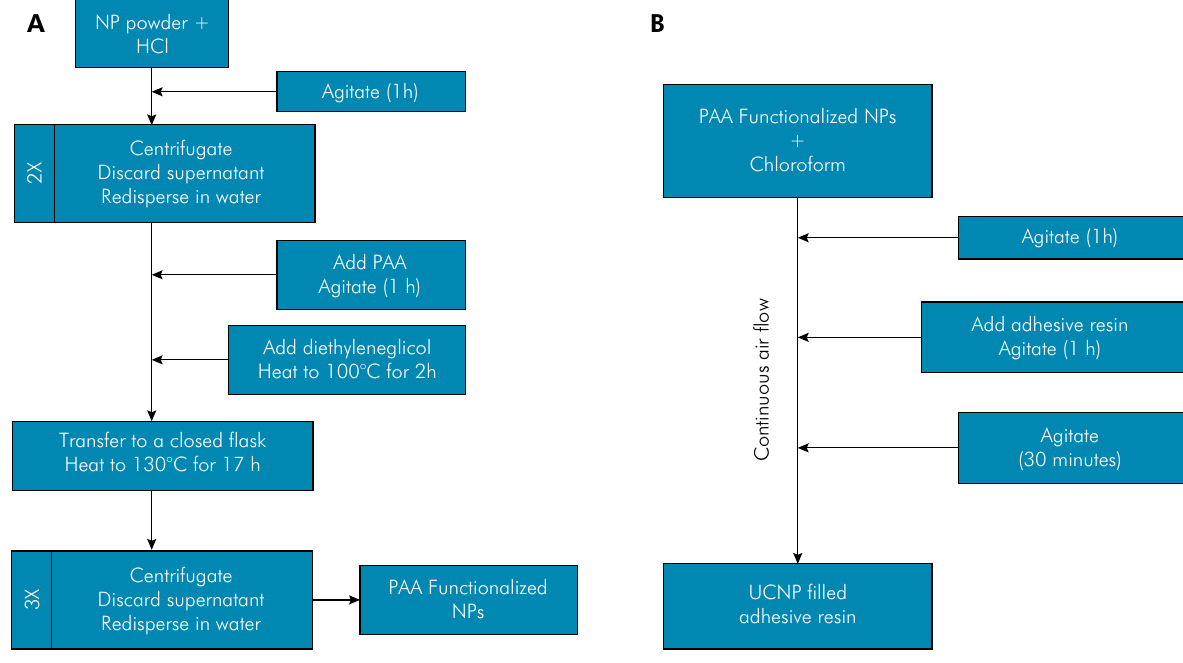
Figure 1. Flowchart summarizing the (A) functionalization and (B) incorporation of the UCNPs into the adhesive resin